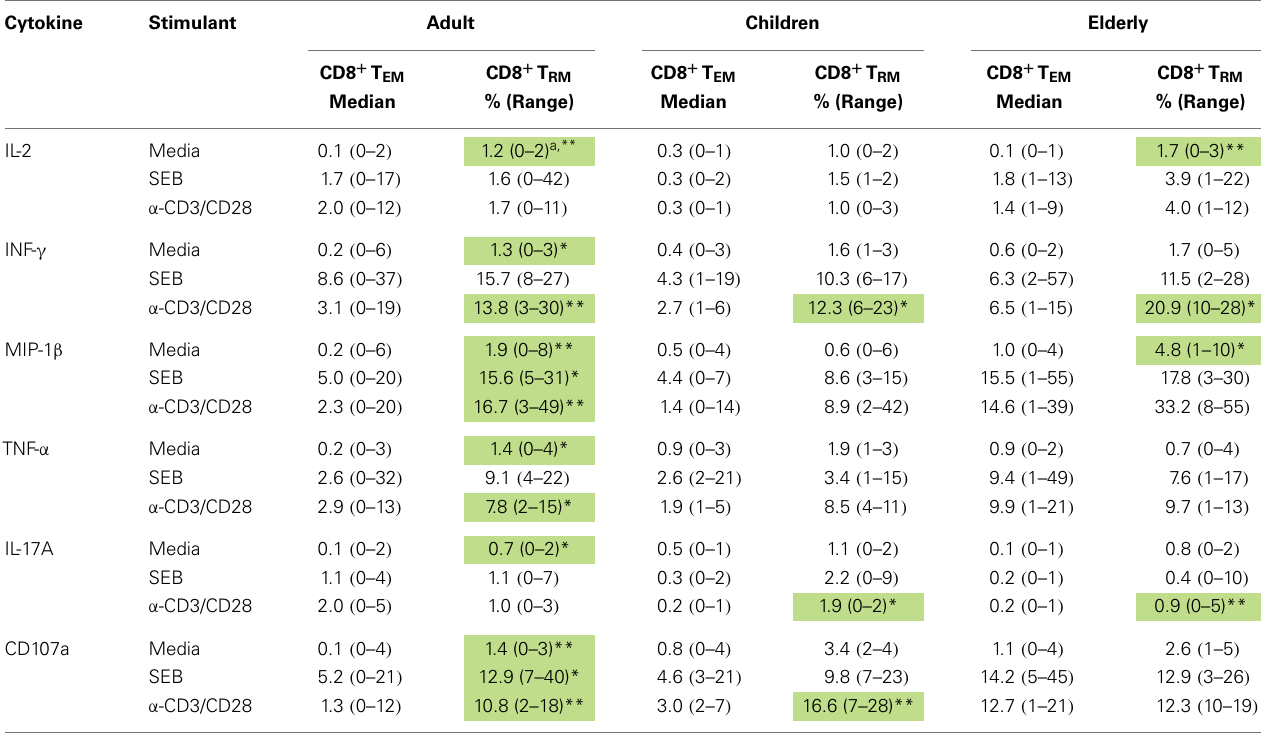
Table 1 | Comparison of PBMC CD8 + T EM and gastric LPMC CD8 + T RM cells activation responses in adult, children, and the elderly .